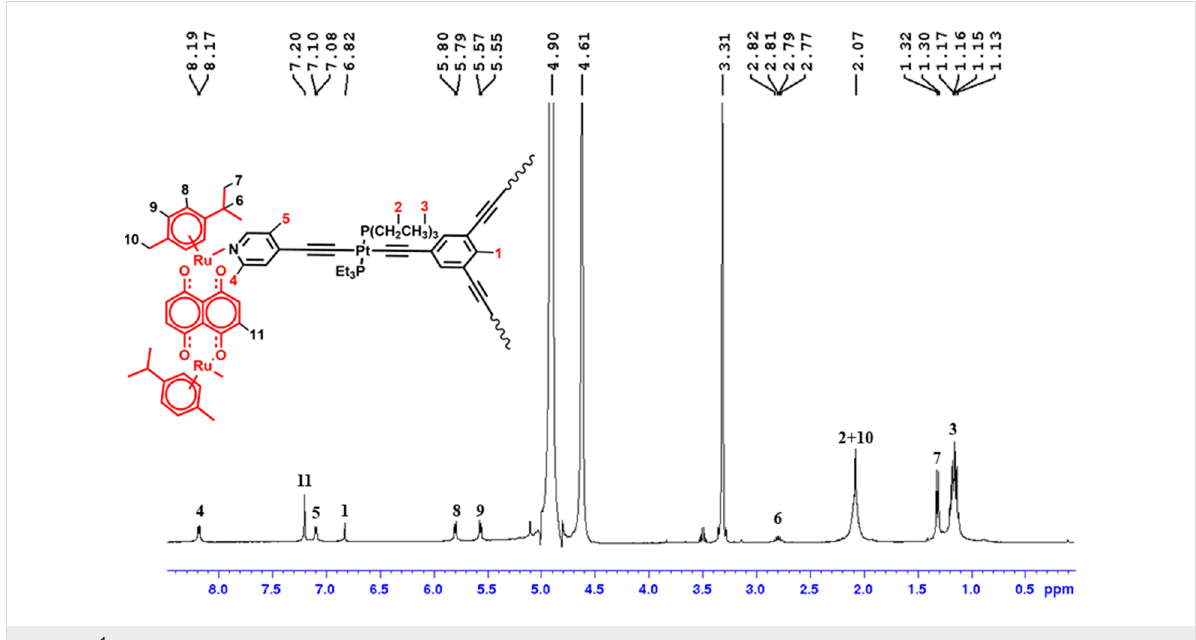
Figure 1: 1 H NMR of 3b in CD 3 OD.